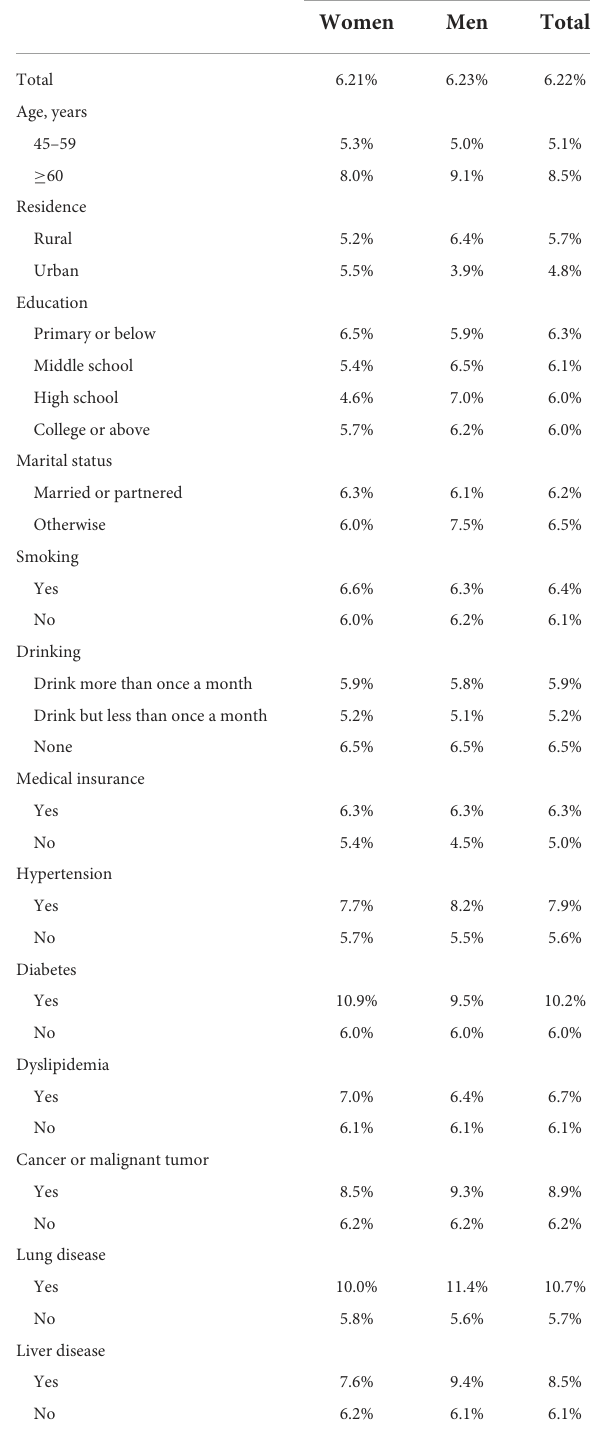
TABLE 2 Prevalence of self-reported history of visual impairment by age, residence, education, marital status, smoking, drinking, chronic diseases, and medical insurance (values are the weighted prevalence of visual